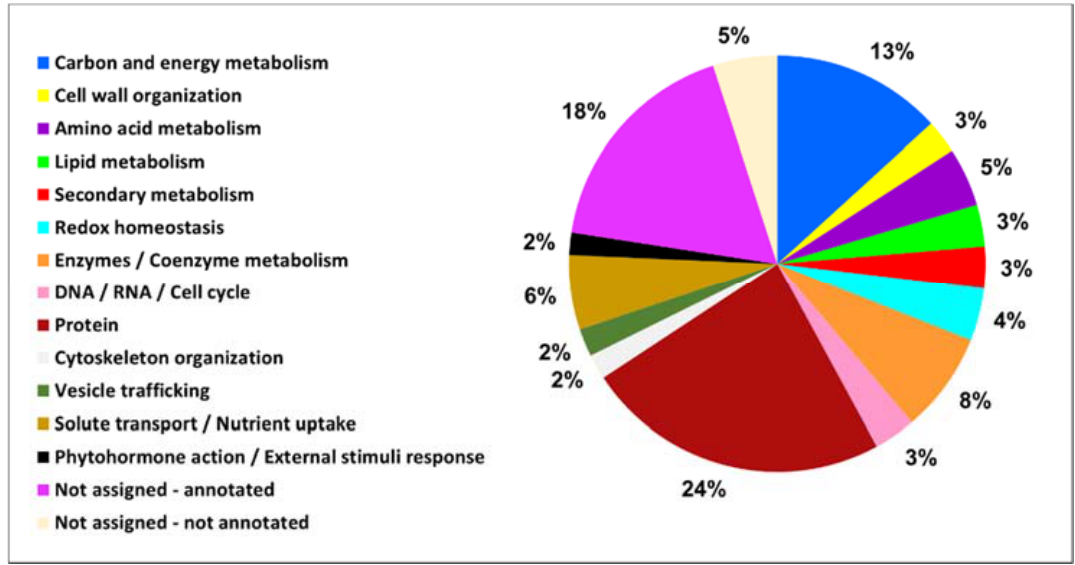
Figure 2. Functional distribution of all the identified proteins in the roots of M4 grapevine rootstock. Proteins were grouped in categories according to BIN ontology.